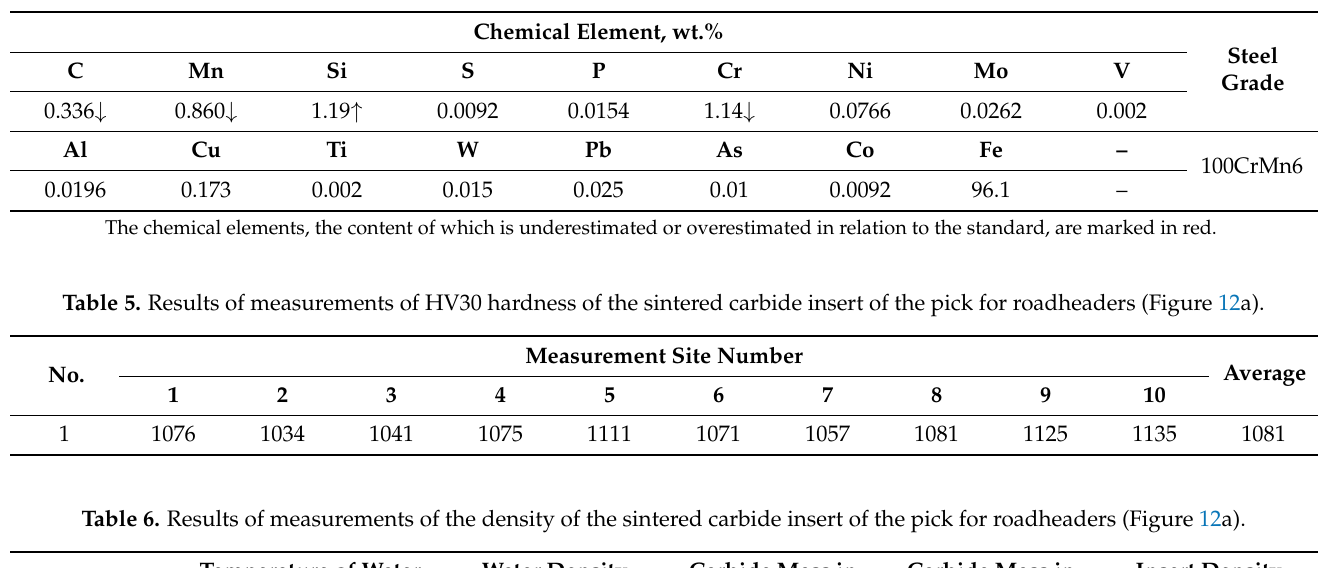
Table 6. Results of measurements of the density of the sintered carbide insert of the pick for roadheaders (Figure 12a). No.